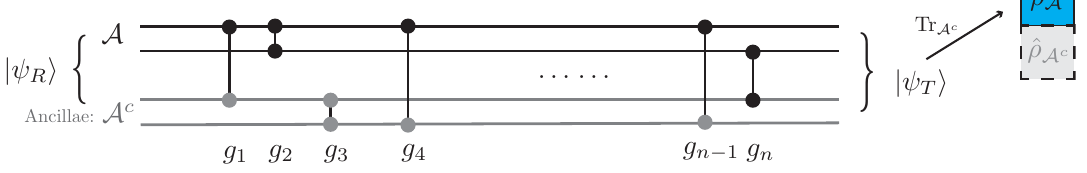
Figure 1 . Circuit with the ancillary degrees of freedom. The mixed state ^ (cid:26) A that we want to prepare is obtained at the (cid:12)nal step after tracing out the ancillae. Circuits with ancillae and puri(cid:12)cation